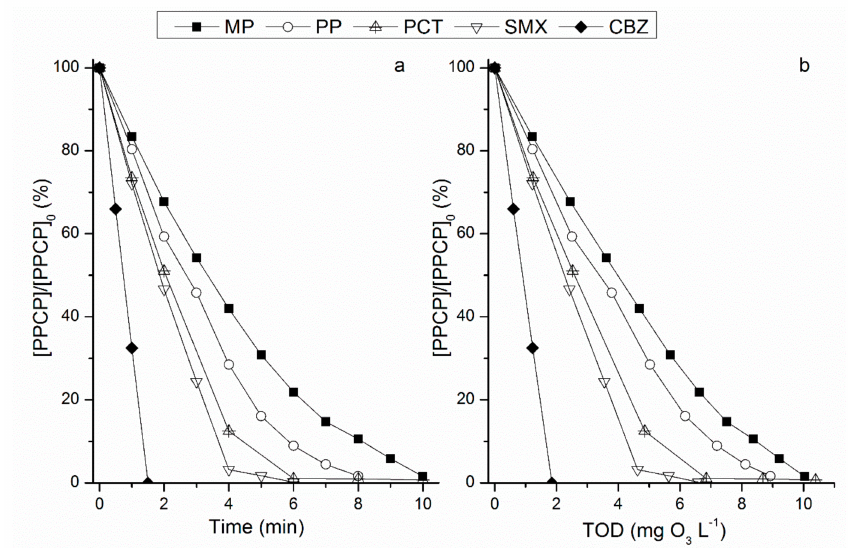
Figure 2. Normalized concentration of methylparaben (MP), propylparaben (PP), paracetamol (PCT), sulfamethoxazole (SMX), and carbamazepine (CBZ) during ozonation as function of time ( a ) and TOD ( b